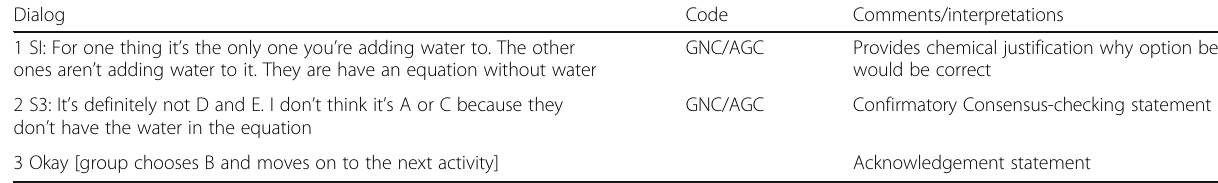
Table 5 Part of group 1C ’ s dialog on choosing the correct equation to represent the dissolution of sodium chloride (NaCl) in water